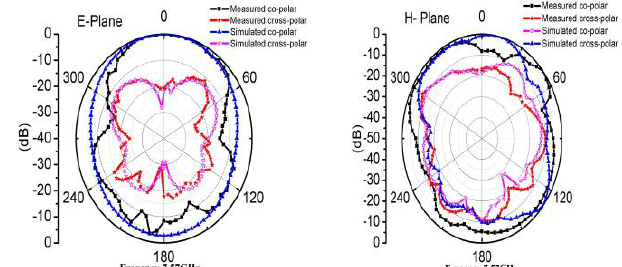
Figure 12: Measured 2d radiation pattern of the proposed antenna with reflector at different frequencies.